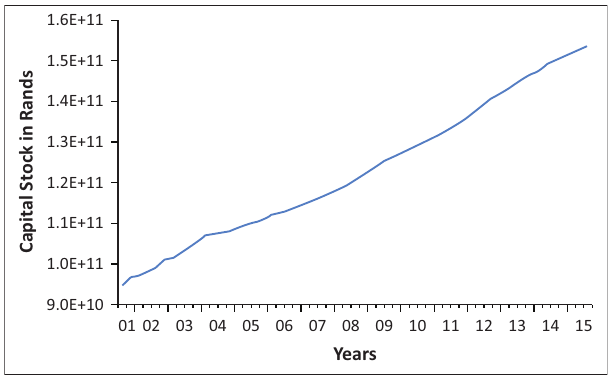
FIGURE 6: Seasonal adjusted fixed provincial government capital stock (2010 prices).